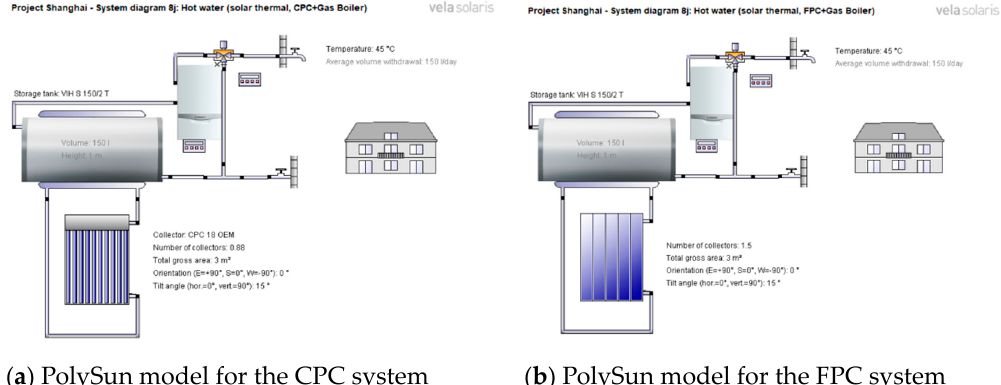
Figure 13. The PolySun model to calculate the solar fraction for CPCs and FPCs. Table 10 The input parameters of the PolySun models.